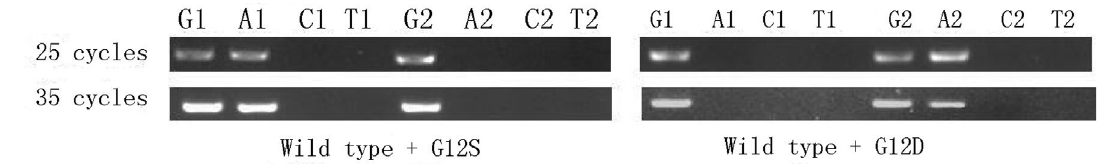
Figure4 -SpecificitydetectionwiththePCRcyclenumbers.G,A,CandTrepresentthefourreactionscorrespondingtoeachpairofdetectionprobes.